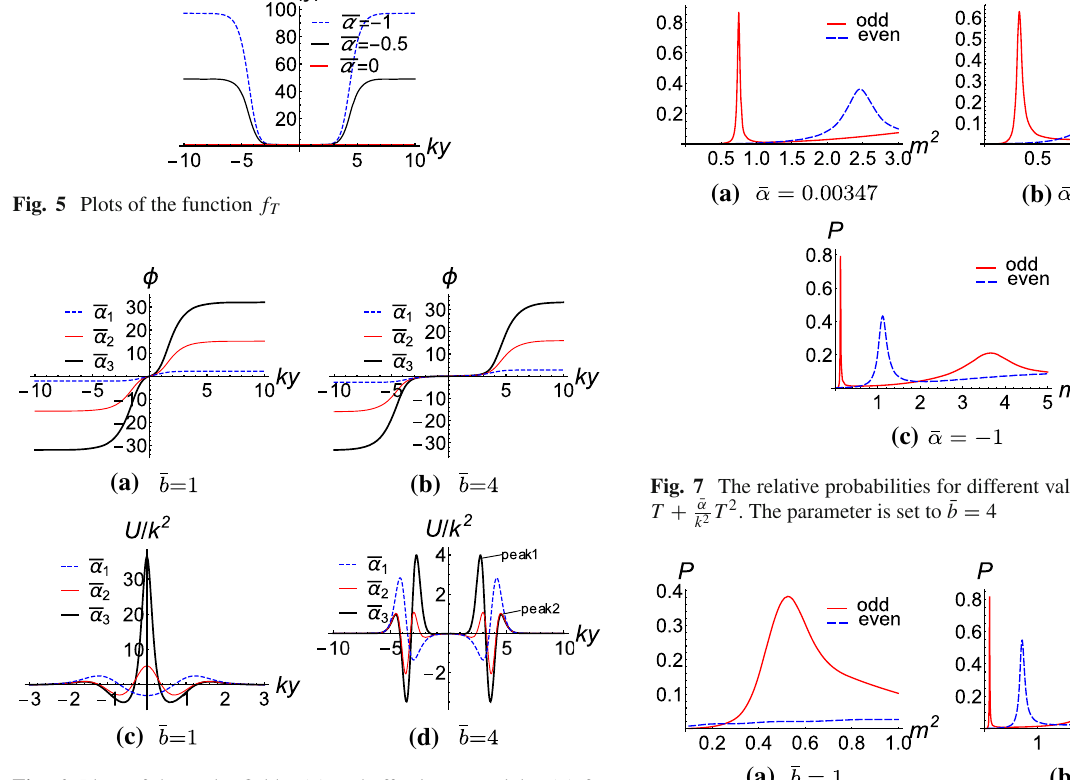
Fig. 6 Plots of the scalar field φ( y ) and effective potential U ( y ) for f ( T ) = T + ¯ α T 2 . The parameter ¯ b is set to ¯ b = 1 , 4. The parameter k 2 ¯ α is set to ¯ α = 1 / 288 ≈ 0 . 00347 (blue dashed lines), ¯ α 1 (red lines), and ¯ α 3 = − 1 (black thick lines)